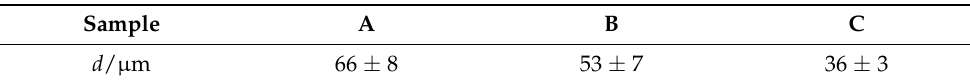
Table 6. Mean grain size in as-stabilized samples, including the standard deviation of the measure- ments.